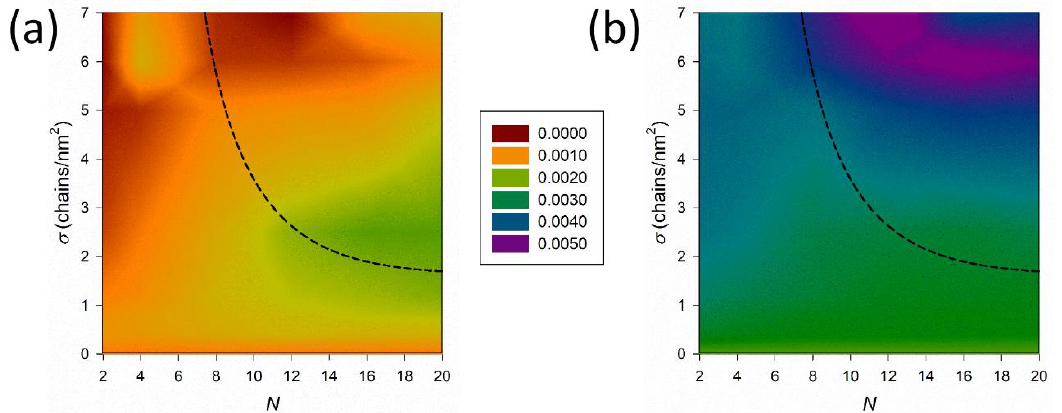
Figure 5. 2D density maps of ( a ) Na + and ( b ) Cl − calculated at water / coating interface and displayed by color-scale in N - σ plane. The black dashed line indicates the brush transition from mushroom to SDPB regime.